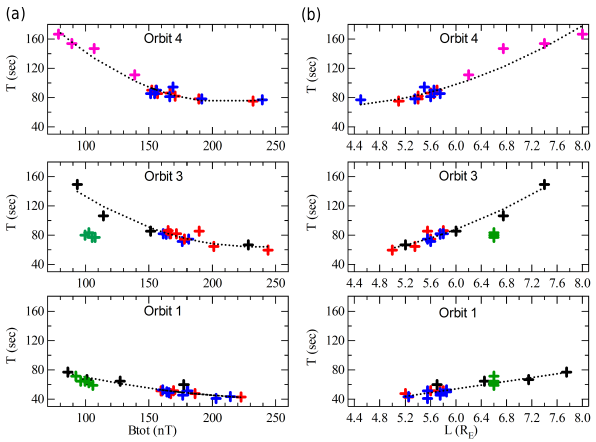
Figure 12. Dominant periods in the spectra of the radial component of the magnetic field observed by Van Allen Probes A (red sym- bols), B (blue symbols), THEMIS D (black symbols) and E (purple symbols), and GOES 15 (green symbols) as a function of the 30min averaged magnetic field strength (a) and L shells (b) . Dashed curves represent polynomial fit with three